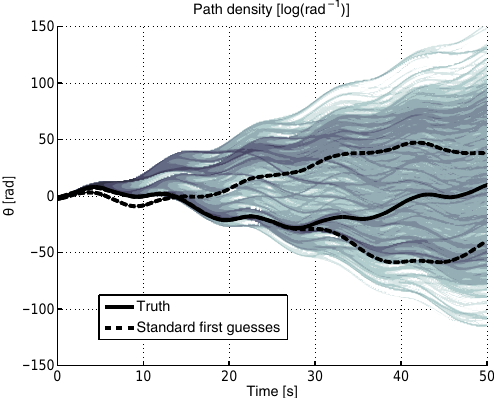
Figure 1. The rapid divergence of pendulum trajectories is indicated by the path density of trajectories (background shading), and the evolution of three sample trajectories: the “truth” or reference tra- jectory (solid line), a “first-guess” trajectory with incorrect initial angular velocity that diverges within 5s (dashed line), and a first- guess trajectory with incorrect initial angle, θ , which diverges after 30s (other dashed line). The path density of trajectories is com- puted with 10000 forward integrations with normally distributed perturbations about the truth (standard deviation: σ ω = 1rads − 1 , σ θ =